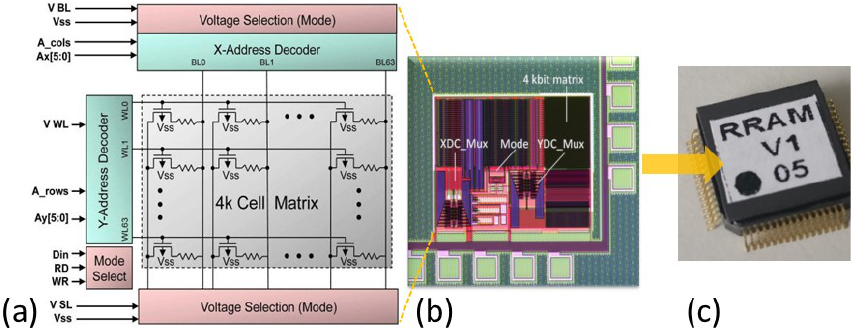
Figure 1. Simplified block diagram ( a ) and micrograph ( b ) of the 4-kbit ReRAM array with the circuit periphery and photograph of the packaged memory chip ( c